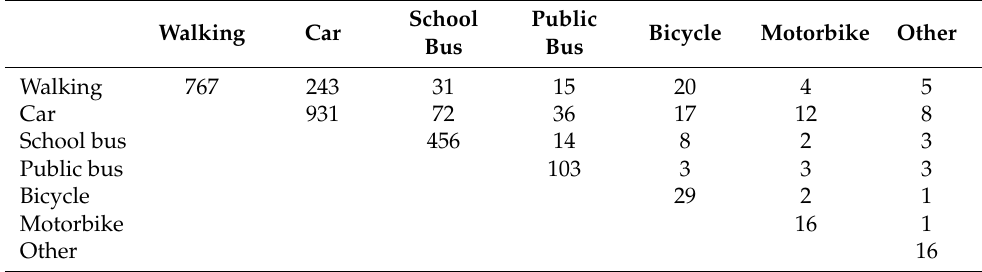
Table 4. Combination of means of transport used to travel to